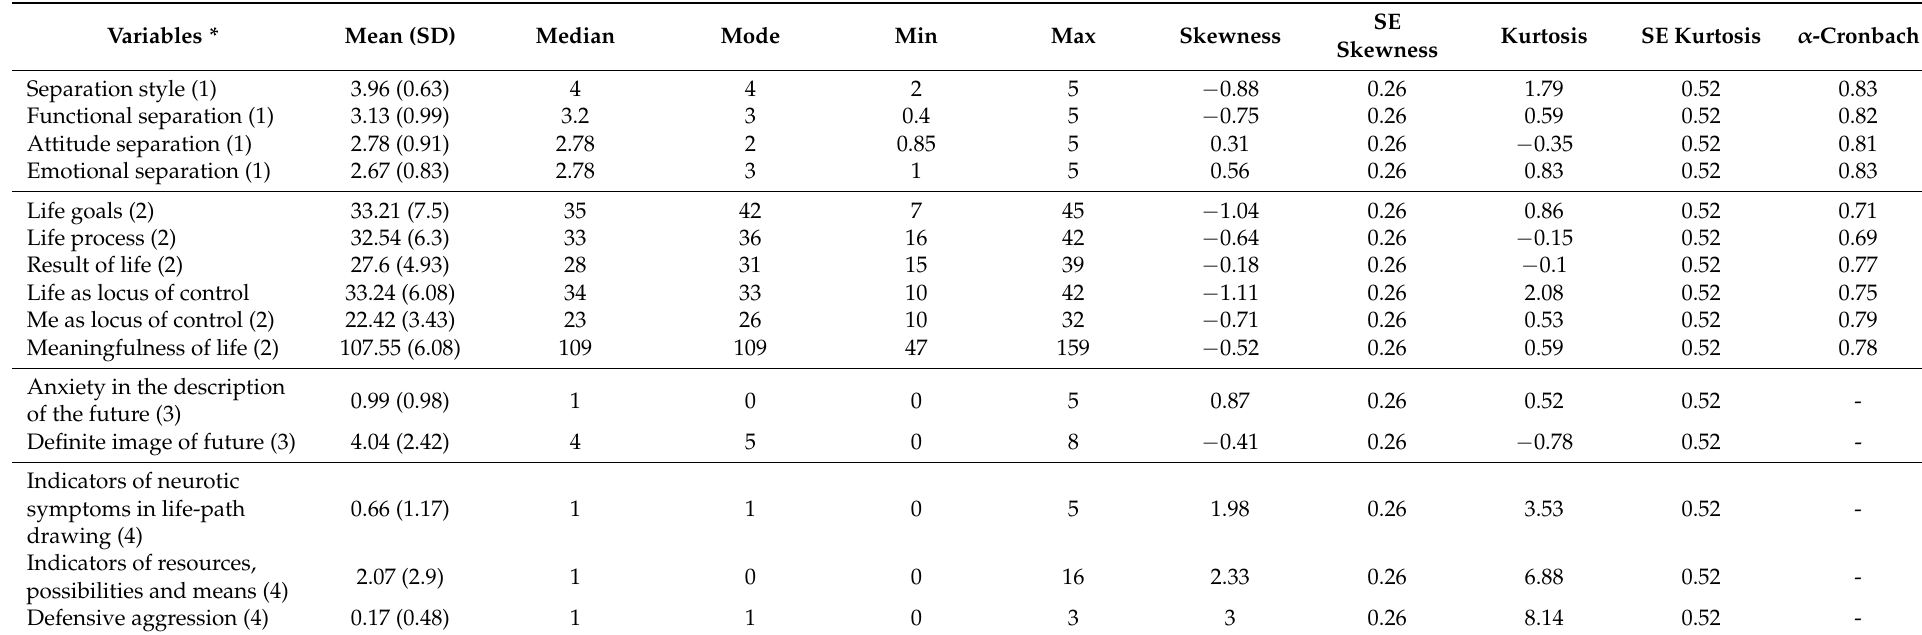
Table A4. Basic descriptive statistics for the variables included in Study 2 ( n =